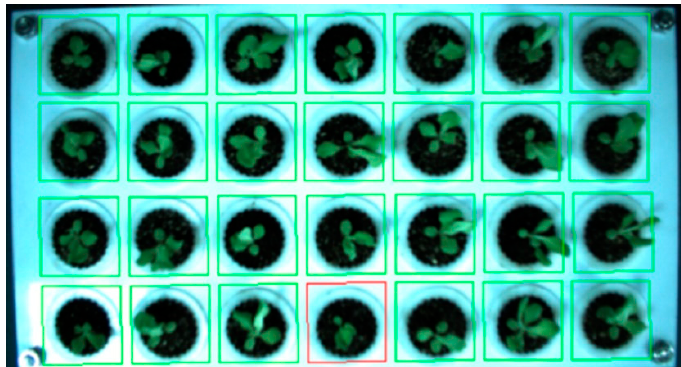
Figure 8. Detection results. Figure 8. Detection